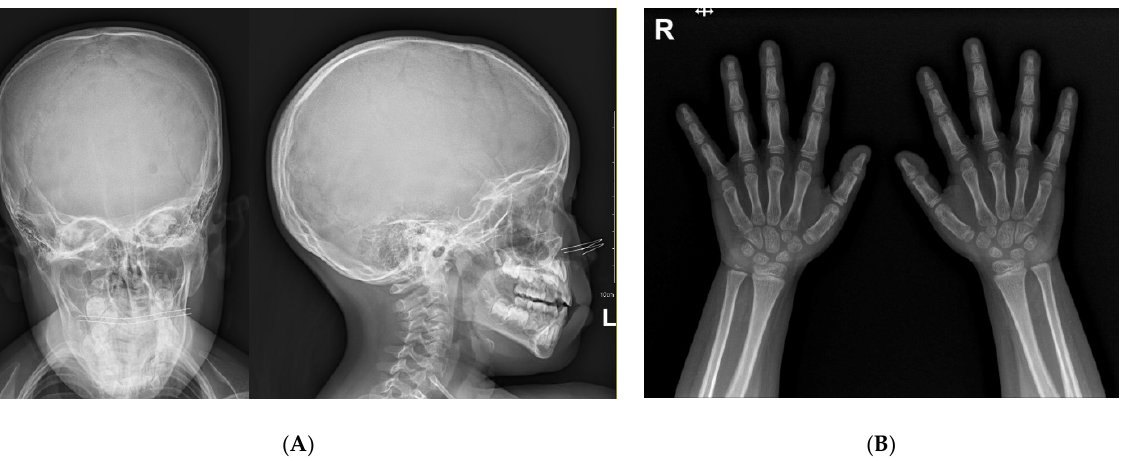
Figure 2. Plain radiography ( A ) Anteroposterior and lateral of skull series. ( B ) Both hand X-rays at chronological age of 4 years and 7 months.